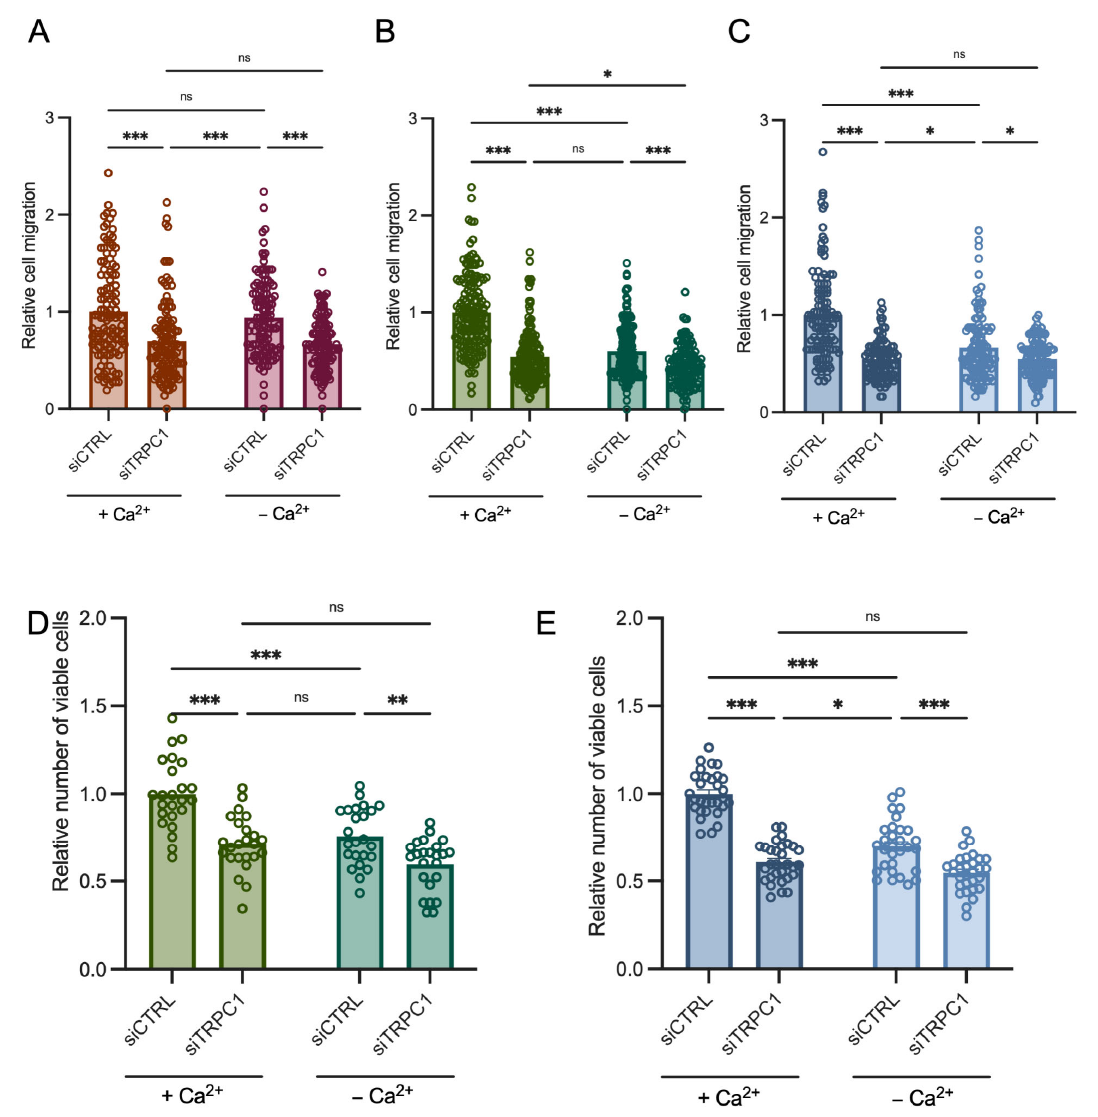
Figure 10. The role of TRPC1 in PANC ‐ 1 cell migration and proliferation shifts from being Ca 2+ ‐ independent in normal pH conditions to being substantially Ca 2+ ‐ dependent in acid adaptation and recovery conditions. ( A ) Boyden chamber assay analysis of transfected PANC ‐ 1 cells grown in normal pH conditions, ( B ) in acid ‐ adapted (6.5) conditions, or ( C ) in acid ‐ recovered (7.4R) conditions. Cells were transfected for 72 h in total. After 48 h, cells were seeded in Boyden inserts for 8 h, and were then treated with medium containing extracellular Ca 2+ concentrations (+ Ca 2+ ), or with a medium depleted of extracellular Ca 2+ ( − Ca 2+ ), for 24 h ( n = 3). ( D ) Trypan blue assay analysis of transfected PANC ‐ 1 cells grown in acid ‐ adapted (6.5) conditions or ( E ) in acid ‐ recovered (7.4R) conditions. Cells were transfected for 72 h in total and either treated with medium containing extracellular Ca 2+ concentrations (+ Ca 2+ ), or with medium depleted of extracellular Ca 2+ ( − Ca 2+ ), for 48 h ( n = 3). Tukey’s multiple comparison test was used to determine significant differences between conditions. ns indicates non ‐ significance. *, **, and *** indicate p < 0.05, 0.01, and 0.001, respectively.